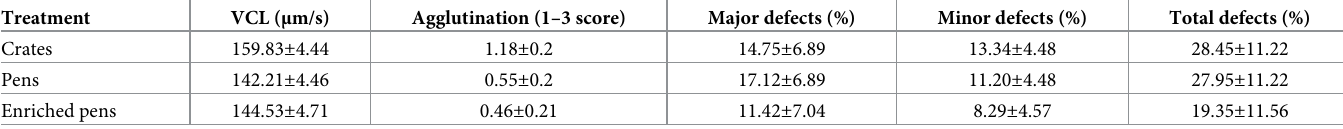
Table 2. The mean values and the standard error mean for the variables differently found on boars housed in three different systems (crates n = 9, pens n = 9; enriched pens n = 9).